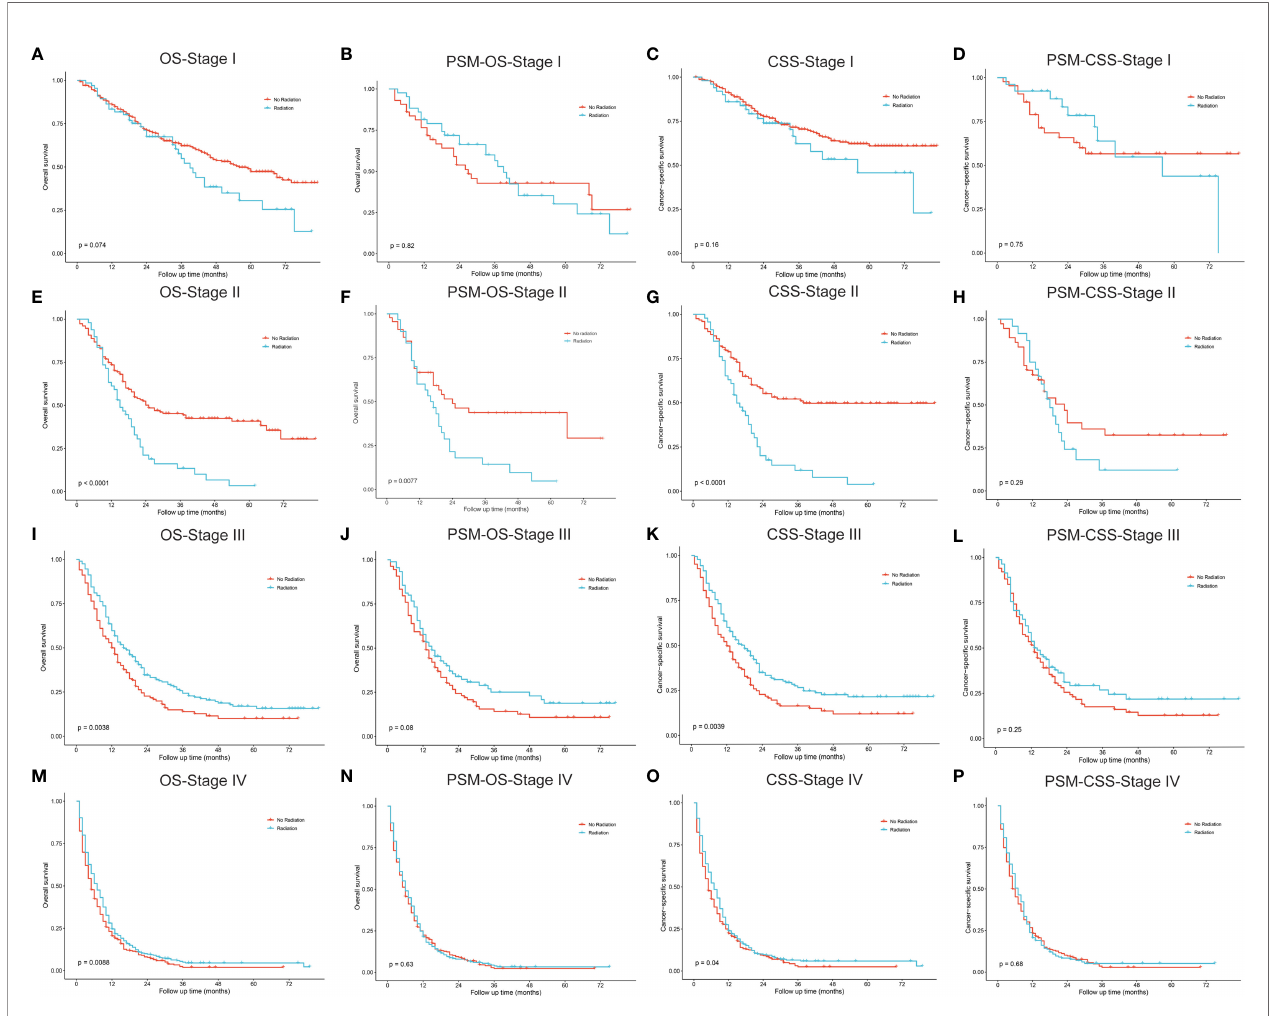
FIGURE 7 | Kaplan – Meier curves for comparisons of radiotherapy vs. no radiotherapy in patients with pulmonary large cell neuroendocrine carcinoma. (A – D) Stage I; (E – H) Stage II; (I – L) Stage III; (M – P) Stage IV. OS, overall survival; CSS, cancer-speci fi c survival; PSM, propensity score